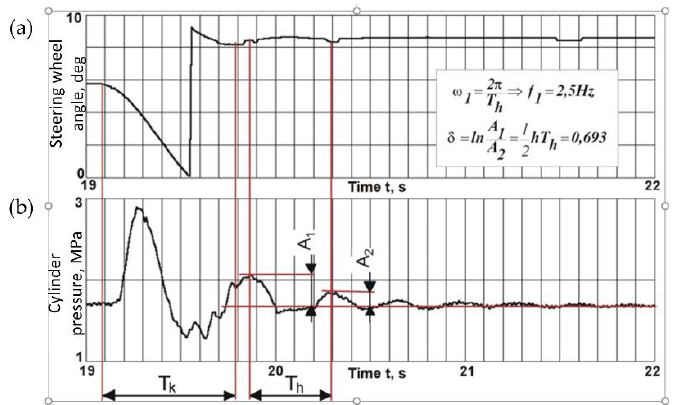
Figure 1. Pressure pulsation in hydraulic actuator of the steering system as a response to steering wheel forcing action—( a ) forcing signal and ( b ) response signal. T s —time of steering wheel turn, and T FD —period of articulated frame oscillation.